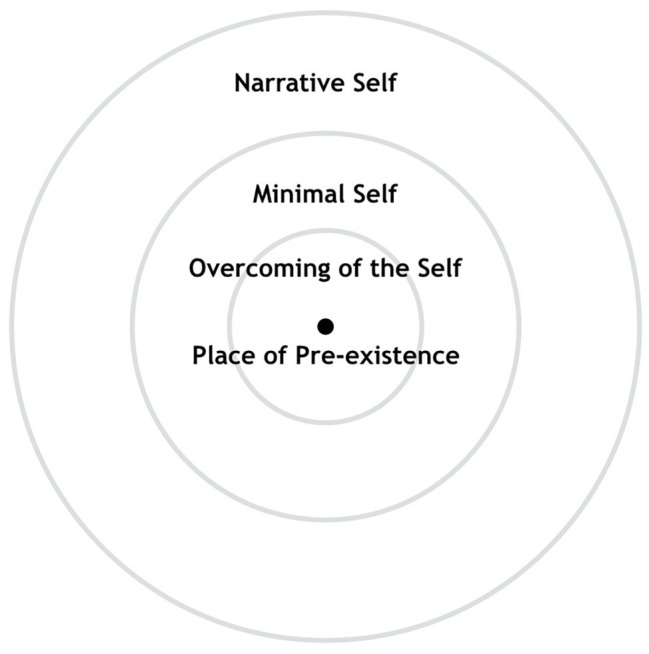
Minimal Self, Narrative Self, and Overcoming of the Self in the SMC. Adapted from Paoletti and Ben-Soussan (2019).